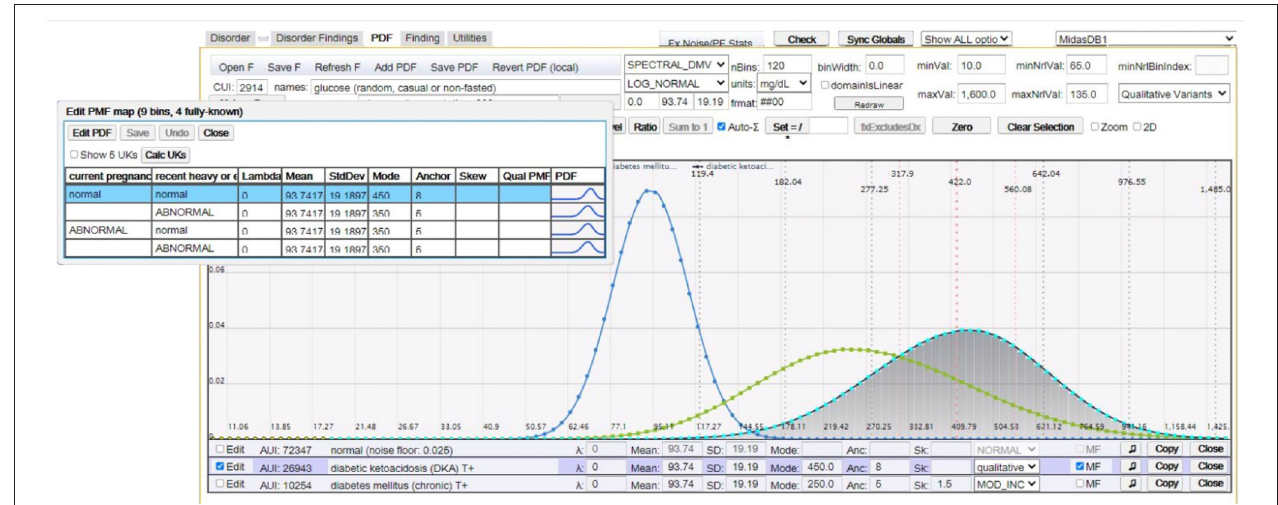
FIGURE 3 | This figure (image captured from our CMS) shows random serum glucose modeled as a log normal distribution for (peak distributions left-to-right): normal (healthy), chronic diabetes mellitus, and DKA. The overlay table in the top left shows multifactorial distributions of serum glucose for DKA as a function of factor findings “current pregnancy” and “recent heavy alcohol